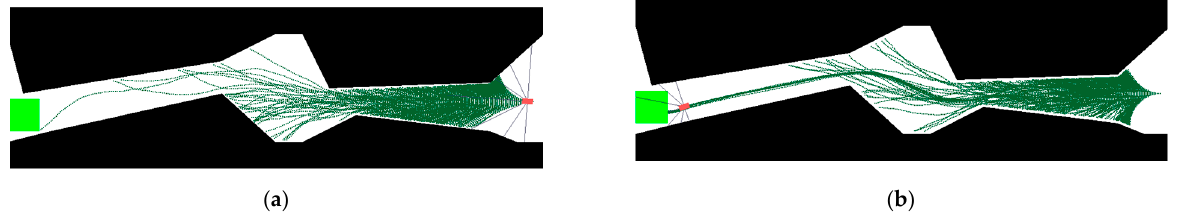
Figure 9. Simulation results of AUV in Environment 1 ( a ) DDPG algorithm AUV path planning method. ( b ) SumTree-DDPG algorithm AUV path planning method. : The walls of unknown underwater canyon; : AUV.